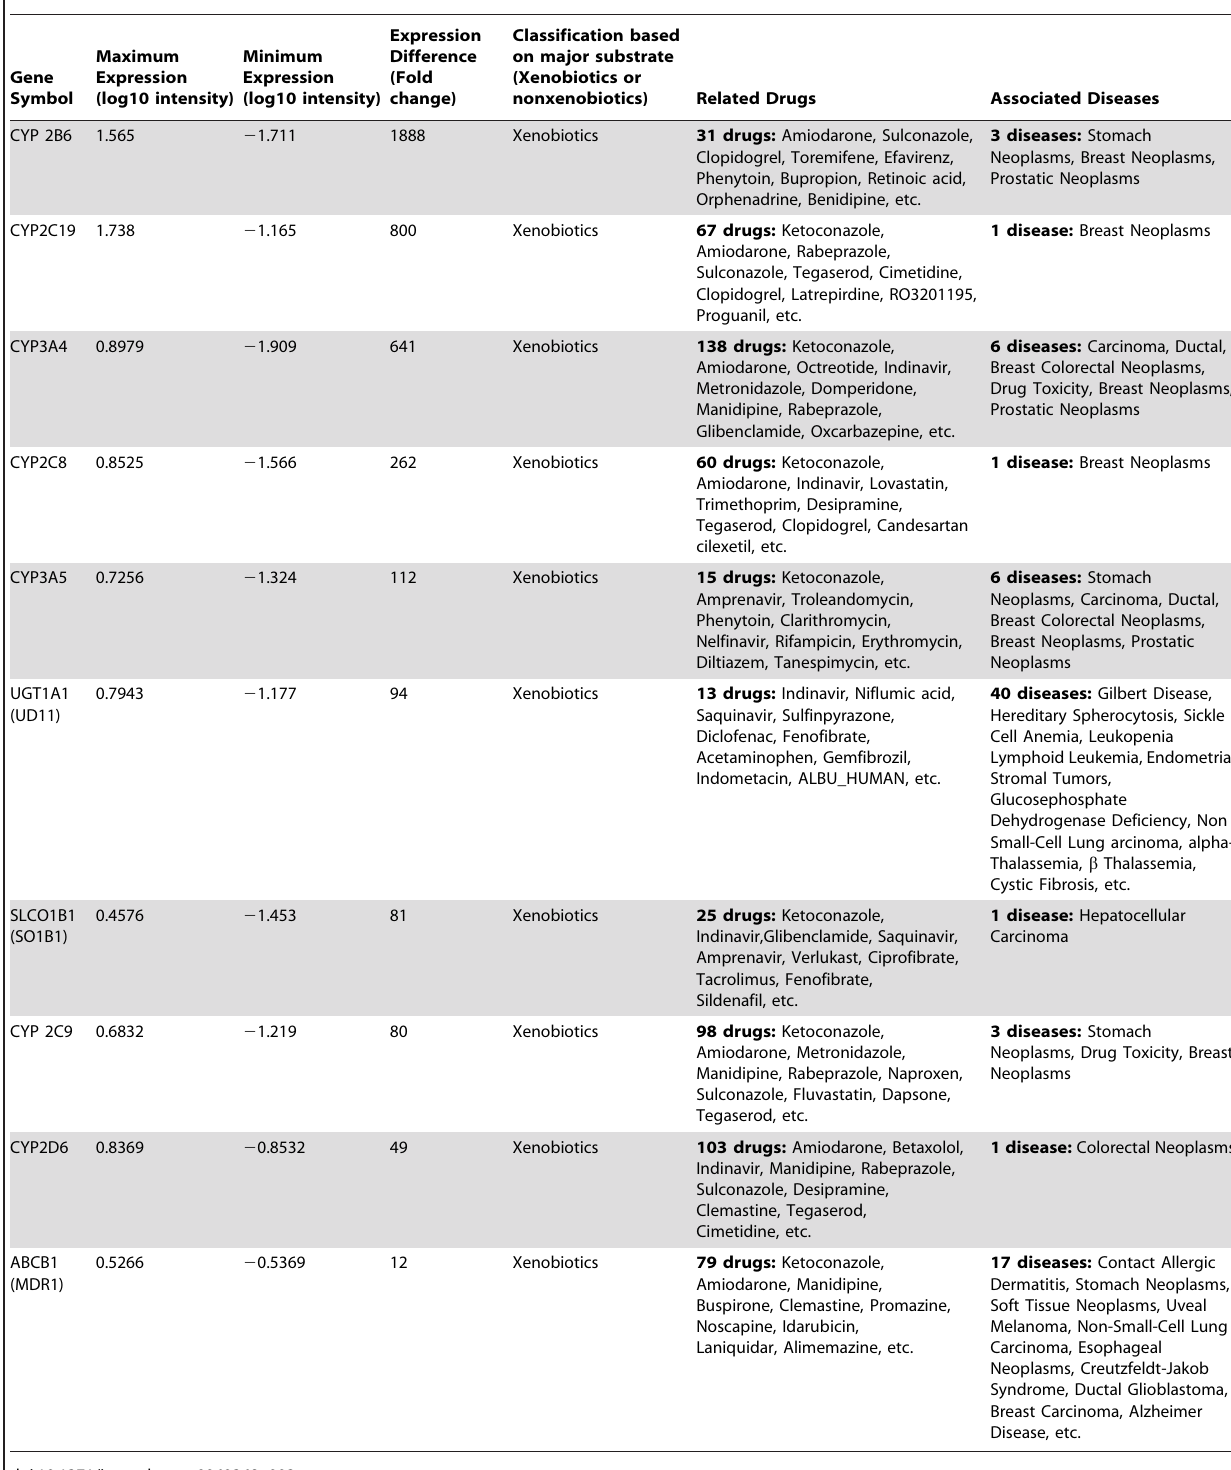
Table 2. Expression Variability of Top 10 Most Important DMETs and Their Biological